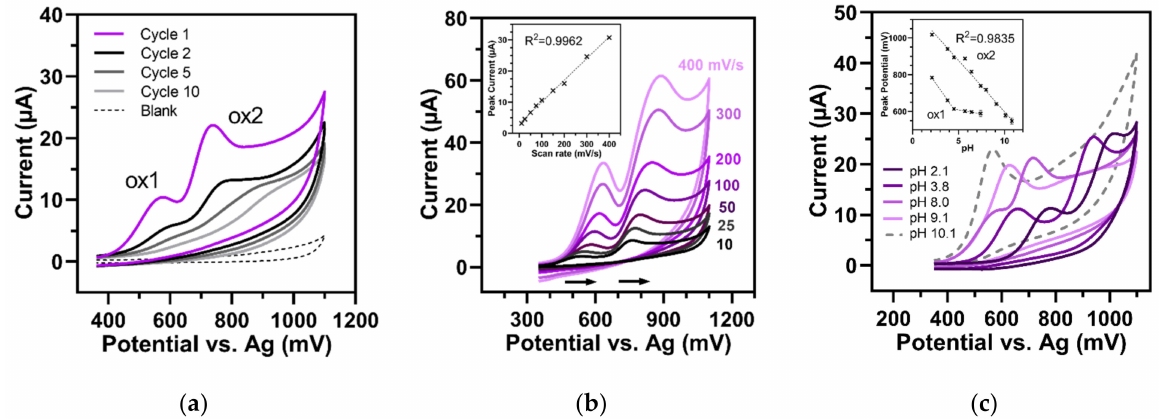
Figure 3. Cyclic voltammetry of 125 µ M PCH (100 mV/s). ( a ) First ten cycles of CV in buffer of pH 7.4. In the first cycle (purple), two defined oxidation peaks (ox1 and ox2) at 580 mV and at 740 mV occurred, which rapidly dropped in the following cycles (black to light grey). Blank = pH 7.4 buffer. ( b ) Rise of the peak amplitudes with elevated scan rates (10 to 400 mV/s, pH 6.4). Arrows show that both peaks shifted towards higher potentials. Insert: Linear regression of peak current versus scan rate (ox1). ( c ) Dependency of peaks on buffer pH. Insert: Shift in oxidation peak potentials of ox1 and ox2 over the whole range (pH 2.1–10.8). Error bars represent the standard deviations of three